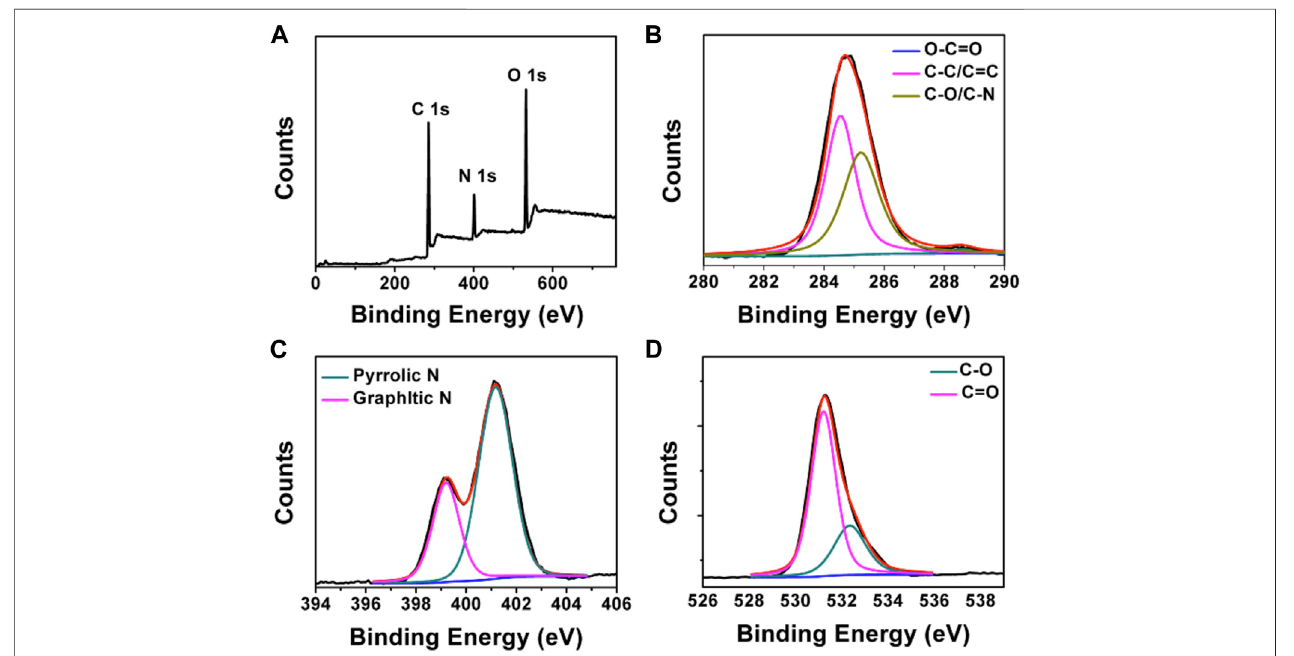
Frontiers in Bioengineering and Biotechnology |